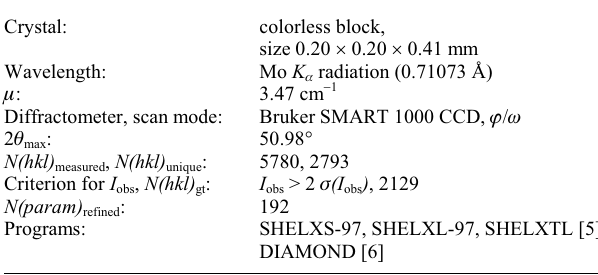
Table 1. Data collection and handling.